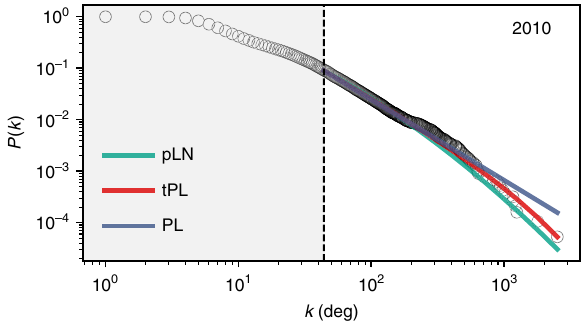
Fig. 3 Degree distribution among stable materials discovered by the year 2010. The complementary cumulative distribution function ( P ( k )) of the degree distribution p ( k ) of stable materials (circles) is plotted along with the fi tted distributions (solid lines). Each point P ( k ) represents the probability that a material has greater than k tie-lines connected to it in the network. Power-law, truncated power-law (with exponential cutoff), and positive log-normal distributions are labeled as PL, tPL, and pLN, respectively. The dashed line shows k min , the lowest degree used in fi tting. Degree distributions of other times are shown in Supplementary Fig.